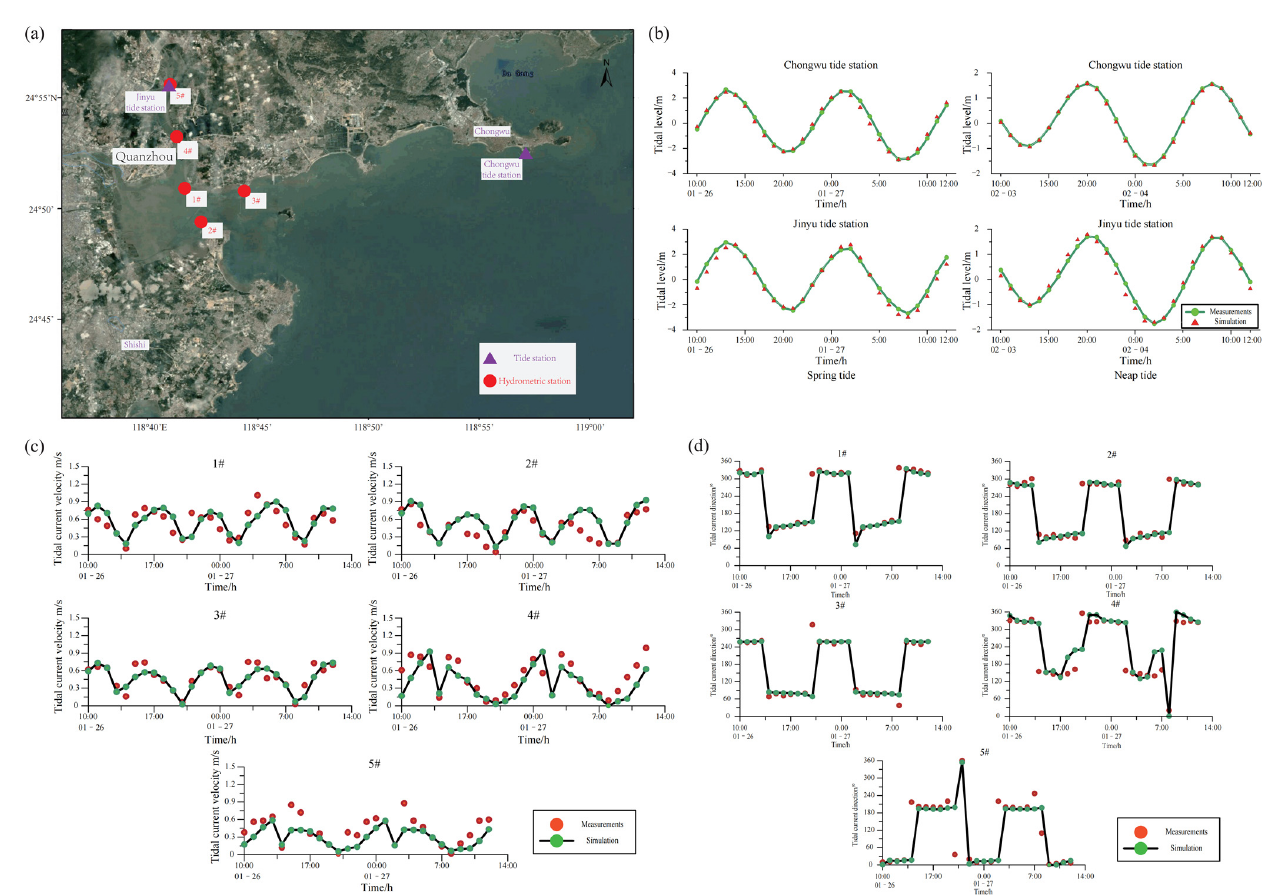
Figure 3. Calibration of the model. ( a ) Location of the tide stations and hydrological stations. ( b ) Comparison of the observed and model-simulated tide levels. ( c ) Comparison of the observed and model-simulated tidal current. ( d ) Comparison of the observed and model-simulated tidal current directions.